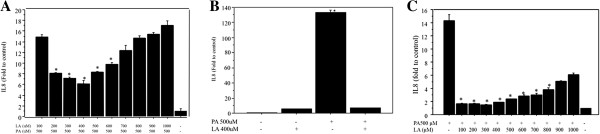
Changes of IL8 mRNA expression following co-incubation with palmitate and linoleate. A. Dose-related changes of IL8 expression following co-incubation with 500 μM palmitate and linoleate (100 to 1000 μM) in Huh7 cells. Dose-related effect of linoleate in the regulation of palmitate-induced IL8 production was assessed following 9 hours of incubation. A 400 μM linoleate showed maximum suppression (n = 4, *p < 0.05). B. Suppressive effect of linoleate against IL8 production induced by palmitate in Huh7 cells. IL8 mRNA expression was significantly lower following co-incubation with palmitate and linoleate (7.33 fold increase; greater than the control, Huh7 cells incubated with bovine serum albumin) than those with palmitate treatment alone (133.5 fold increase, n = 6, *p < 0.0001). A co-incubation with 400μM linoleate showed suppression of IL8 expression with 94.5% decrease compared to the cells treated by 500μM palmitate alone. C. Dose-related changes of IL8 expression following co-incubation with 500 μM palmitate and linoleate (100 to 1000 μM) in HepG2 cells. Dose-related effect of linoleate in the regulation of palmitate-induced IL8 production was also assessed following 9 hours of incubation in HepG2 cells. A 300 μM linoleate showed maximum suppression with 87.1% decrease compared to the IL8 expression in the cells treated by 500 μM palmiate alone (n = 4, *p < 0.01).